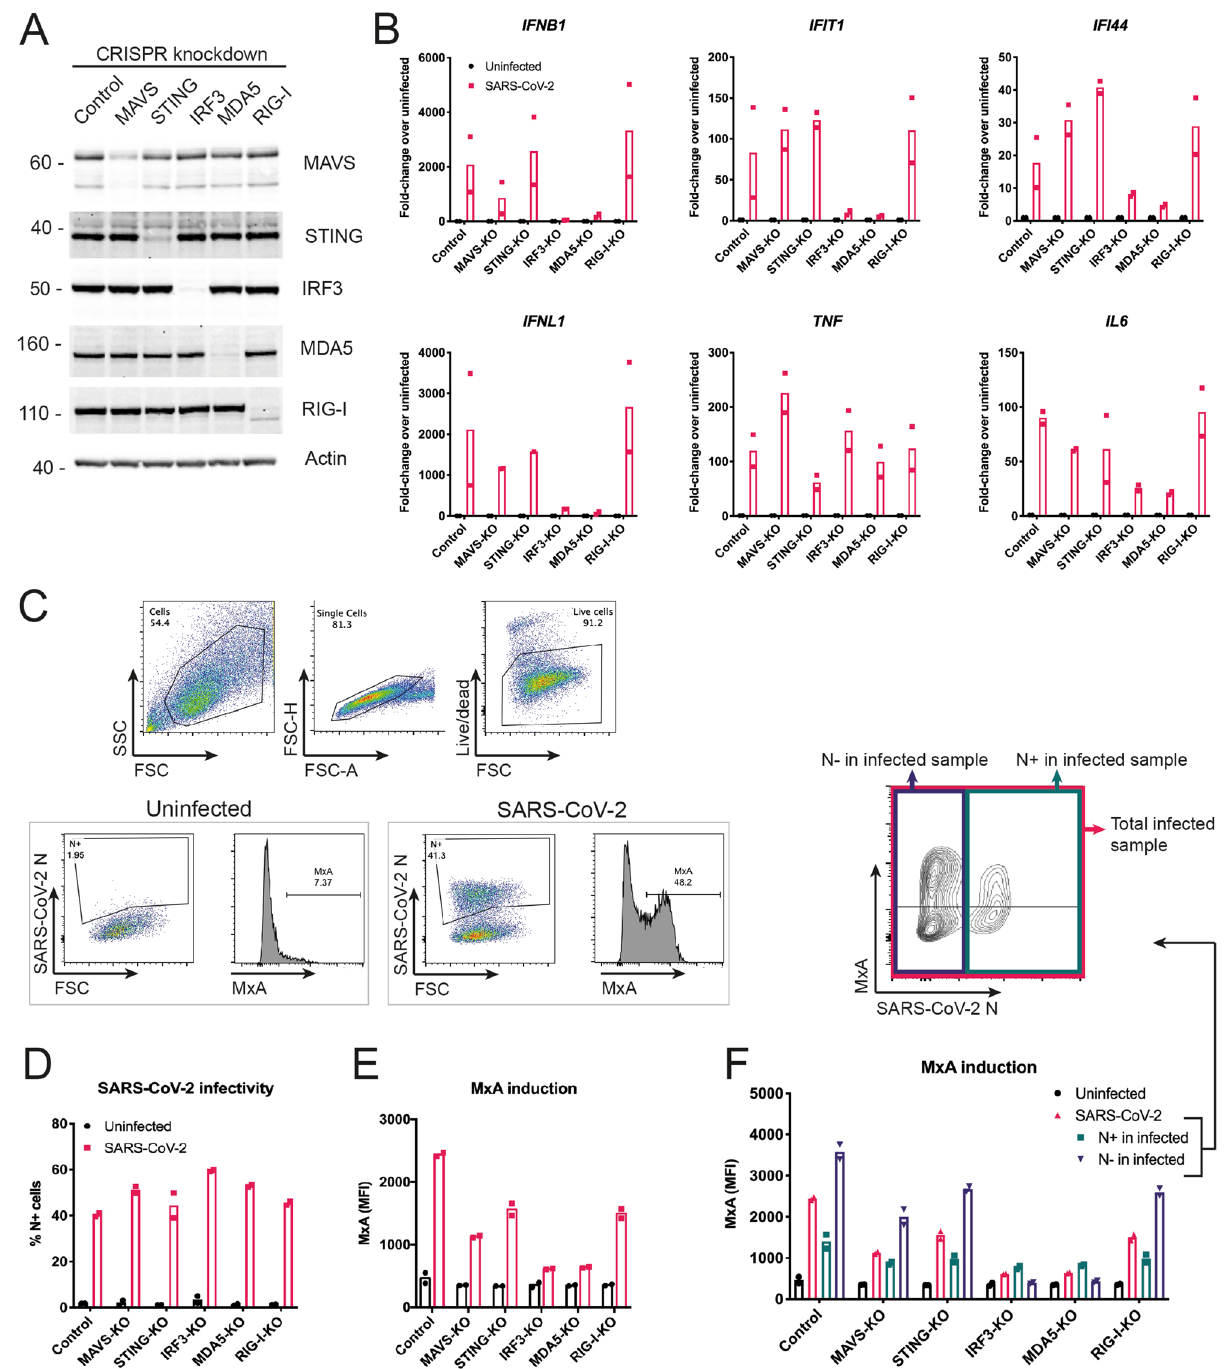
Figure 3. SARS-CoV-2 activates type I and III IFN responses via MDA5 and IRF3, and inhibits ISG induction in infected Calu-3 cells. ( A ) Calu-3 cells were depleted of MAVS, STING, IRF3, MDA5 or RIG-I using a lenti-CRISPR approach. Depletion of the targeted proteins was assessed by western blot. Control cells were targeted for GFP, which is absent in Calu-3 cells. See Supplementary Figure 4 for full blots. ( B ) Cells from ( A ) were infected and analysed as described in Fig. 2C. ( C – F ) Cells from ( A ) were infected as in Fig. 2C, stained for live cells, SARS-CoV-2N protein and MxA, and analysed by flow cytometry. Live cells were assessed for SARS-CoV-2 N protein expression ( D ) and MxA induction, shown as mean fluorescence intensity (MFI; E ). ( F ) Cells in the SARS-CoV-2-infected samples were further subdivided into SARS-CoV-2 N positive (N+) and SARS-CoV-2 N negative (N−) cells, and MxA MFI was determined within these subpopulations. Data in ( A , C ) are representative of two independent biological repeats. Data in ( B , D – F ) are pooled from two independent biological repeats, with bars representing the